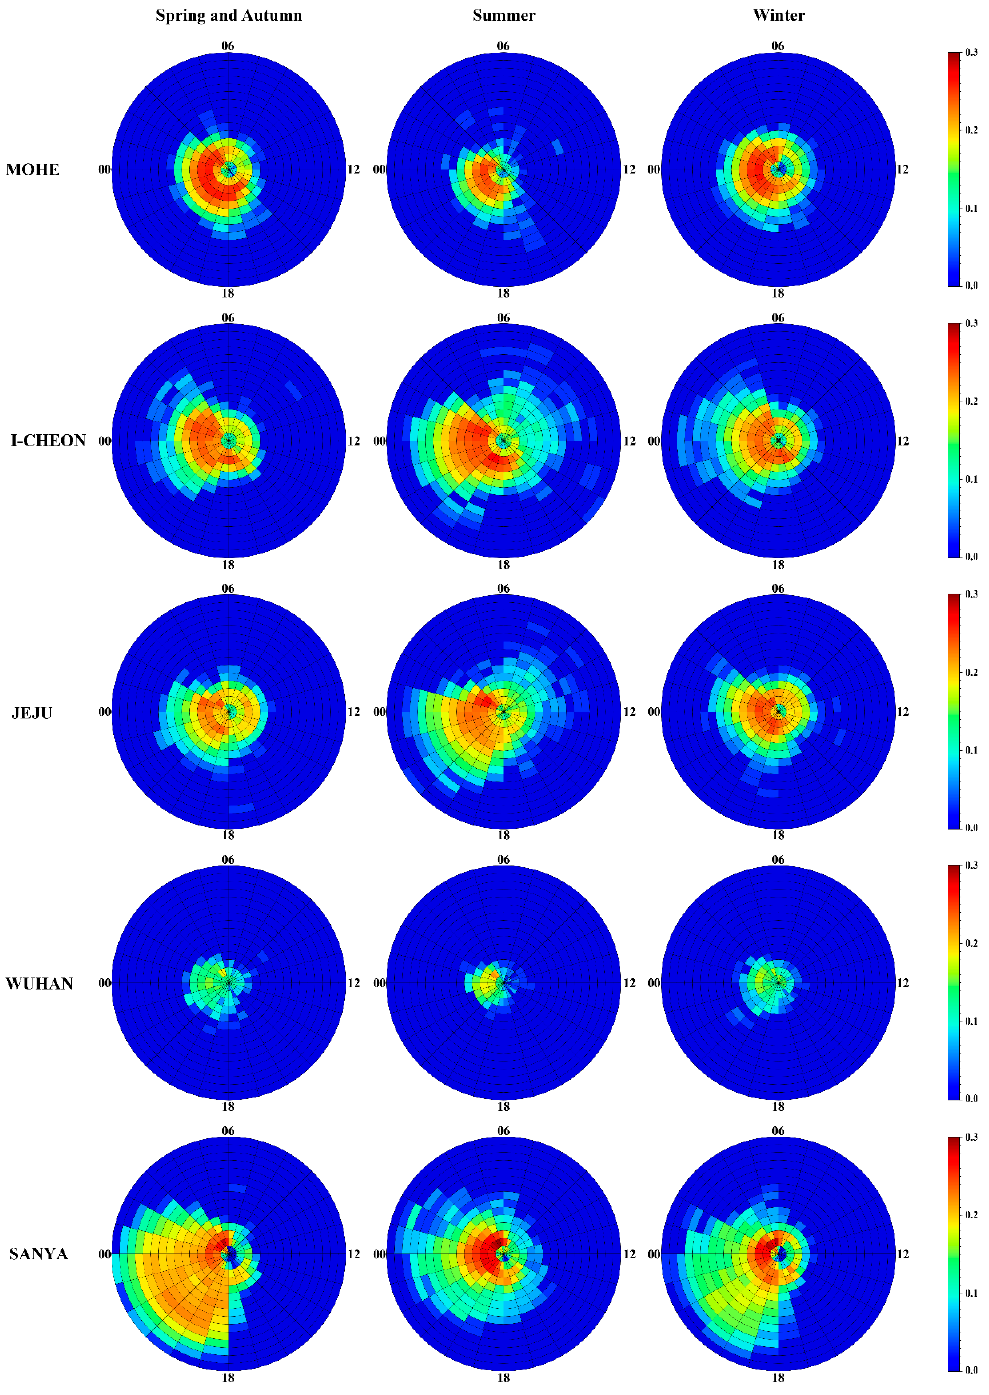
Figure 6. Seasonal distribution of RSF index in Mohe, I ‐ Cheon, Jeju, Wuhan, and Sanya within the same grid as Figure 5.